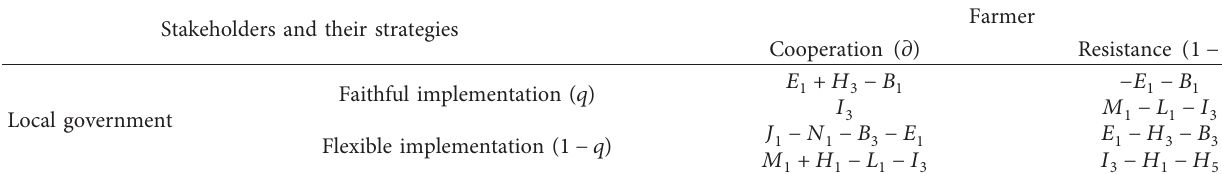
Table 2: Payoff matrix of the local government and